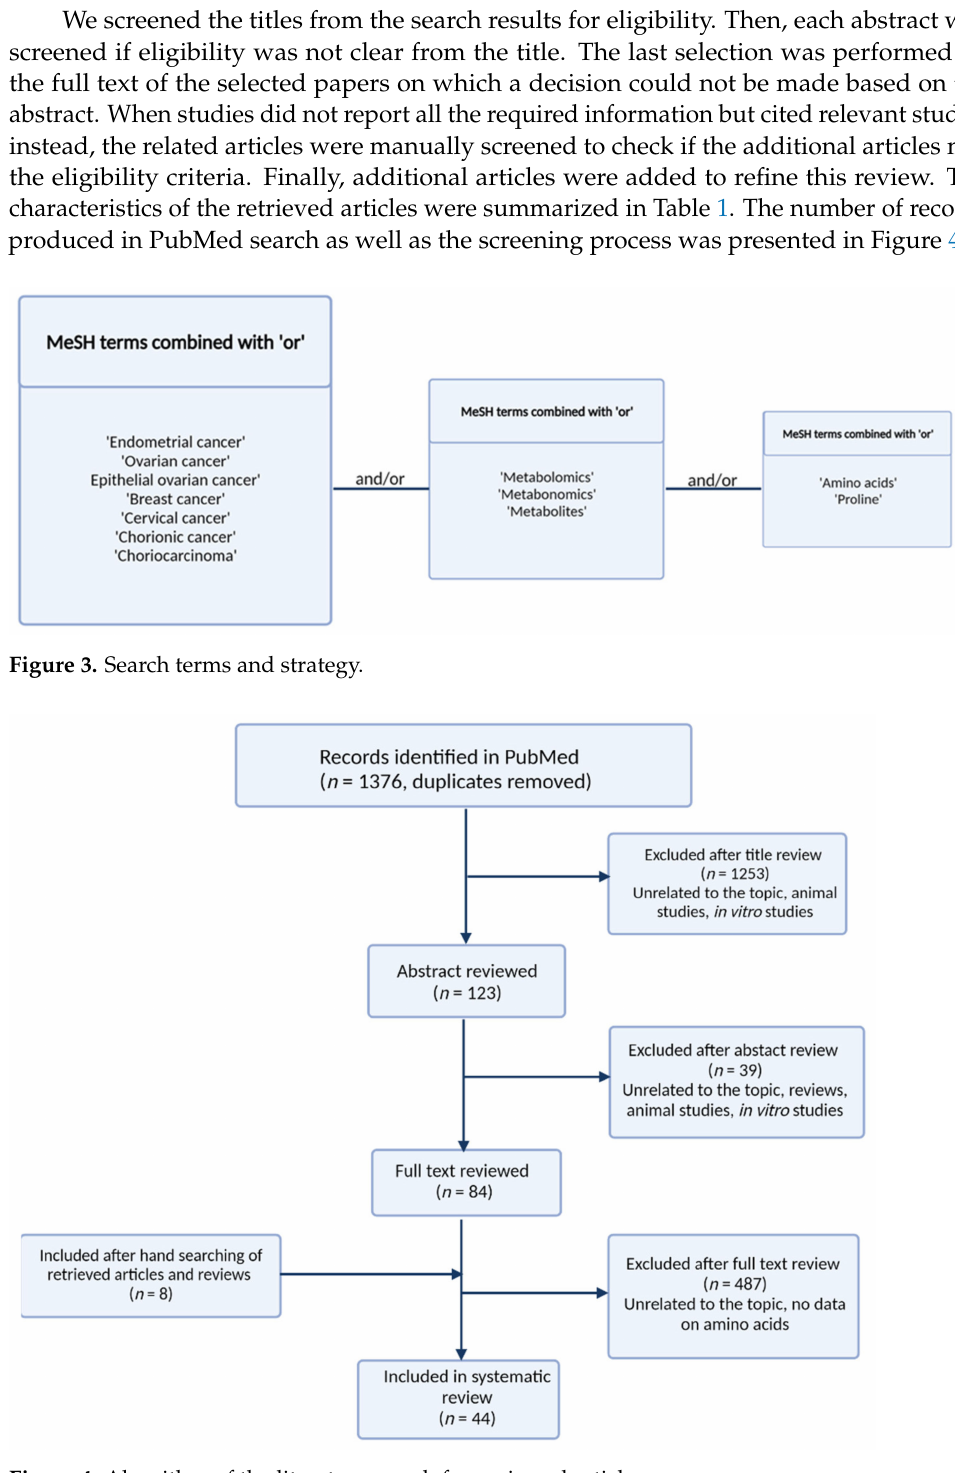
Figure 4. Algorithm of the literature search for reviewed